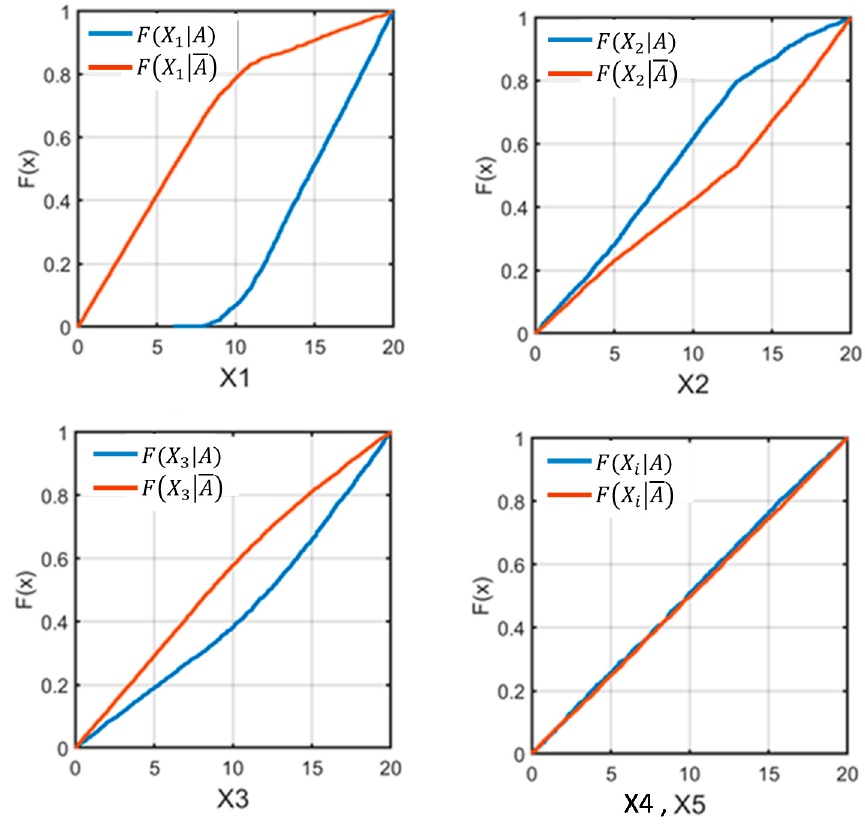
Figure 11 . Cumulated density functions 𝑭𝐗𝒊 | 𝑨 and 𝑭𝐗𝒊 | 𝑨 for each input 𝑿𝒊. Figure 11. Cumulated density functions F X i | A and F X i | A for each input X i